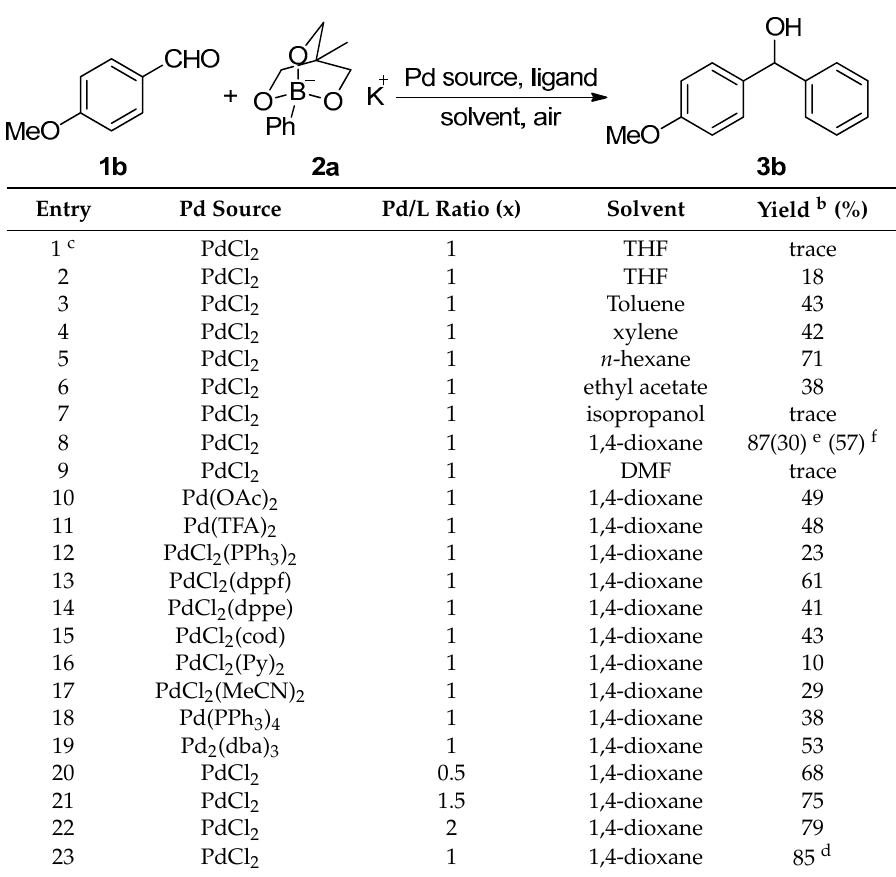
Table 1. Optimization of the reaction conditions a .